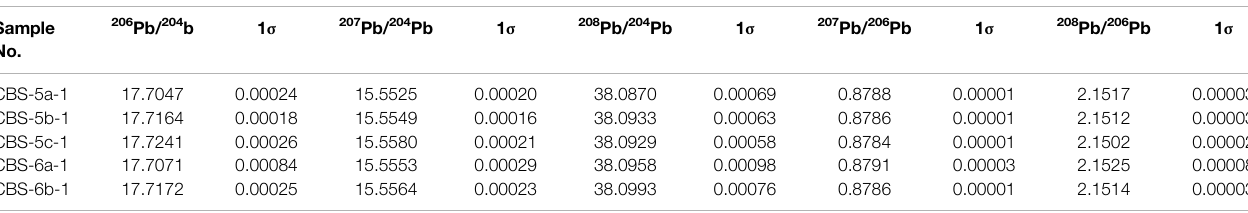
TABLE 4 | Lead isotope compositions of trachybasalt dikes in the study area. Sample